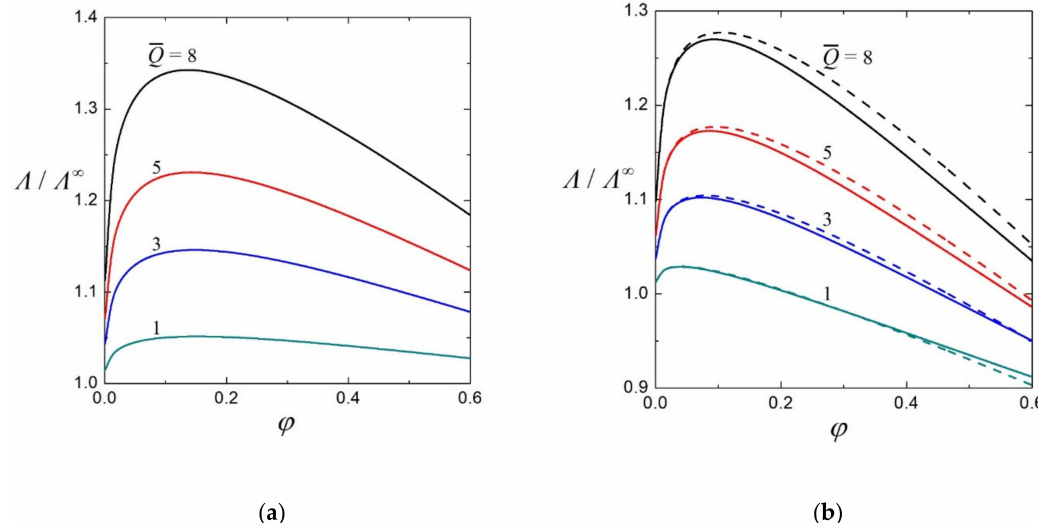
Figure 8. Normalized effective electric conductivity Λ / Λ ∞ versus ϕ with Q as a parameter for a suspension of soft spheres: ( a ) r 0 / a = 0 (porous spheres); ( b ) r 0 / a = 1/2 with the solid and dashed curves denoting results obtained from conditions (13) and (14), respectively, at the cell